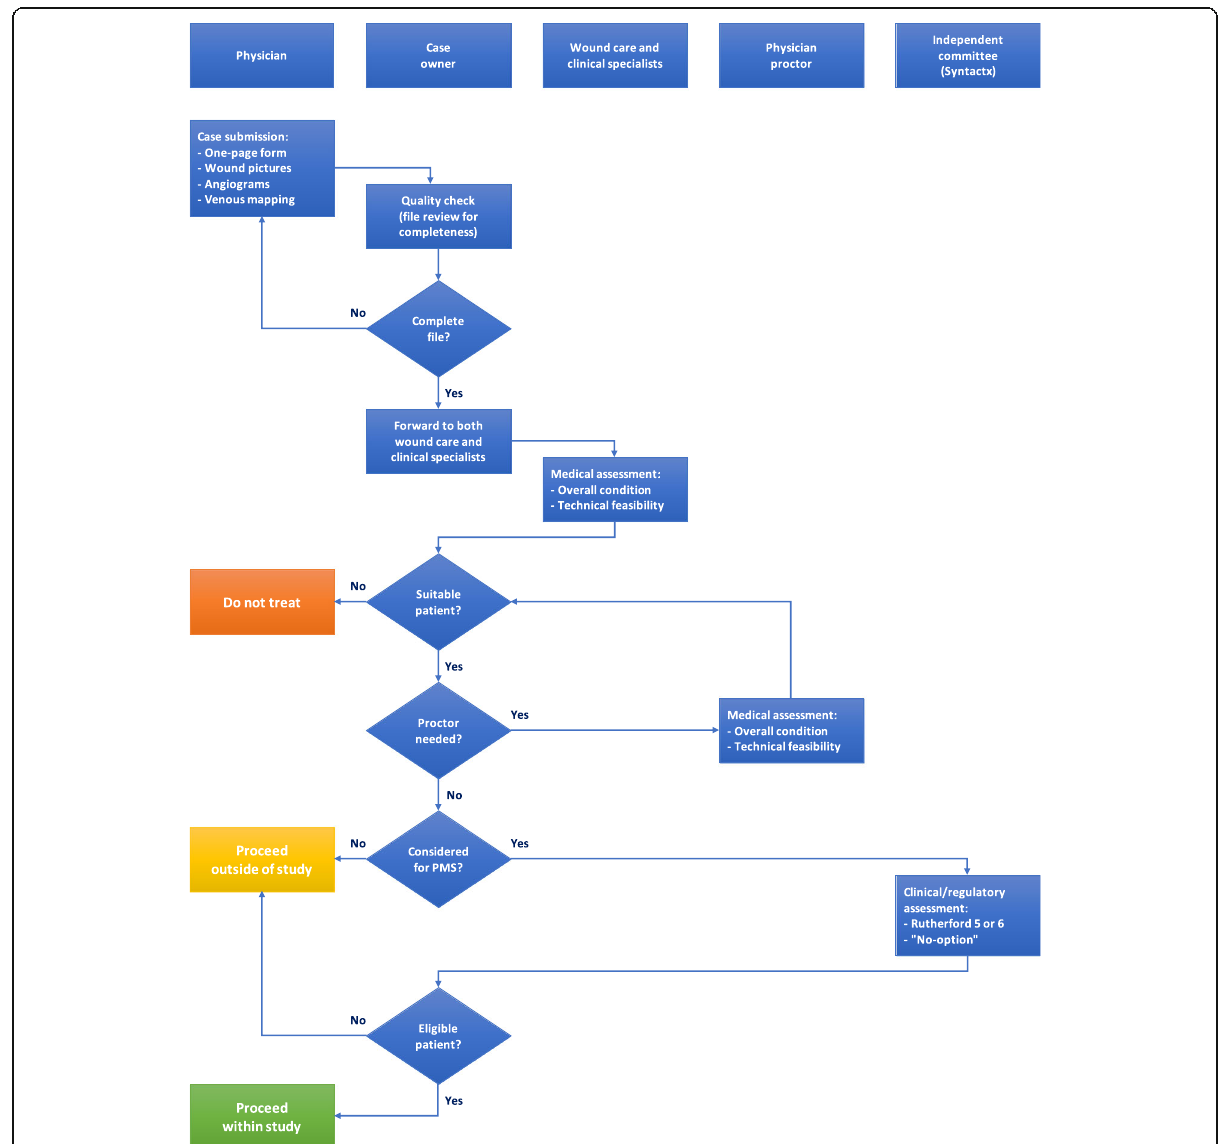
Fig. 1 Eligibility screening process for LimFlow